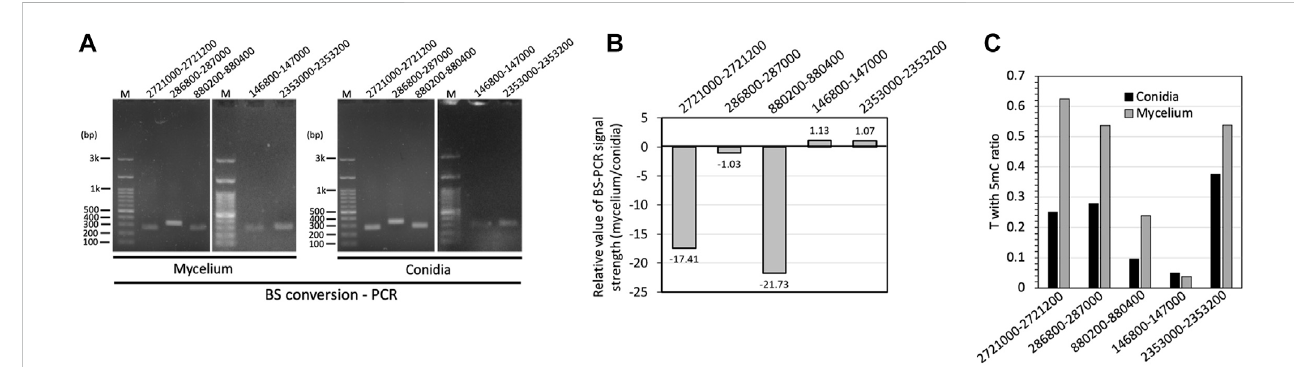
FIGURE 7 Validation of DMRs among two fungal developmental stages by BS conversion PCR. (A) DNA electrophoresis gel of PCR ampli fi ed from BS converted mycelium and conidia DNA samples. (B) Semiquantitative BS-PCR based on the relative values of mycelium to conidia. (C) Ratios of T with C signal in Chromatograms of Sanger sequencing in mycelium and